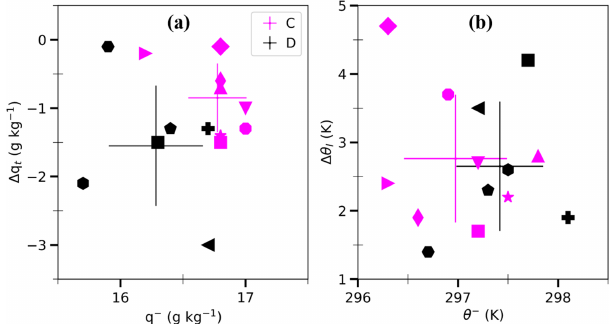
Figure 8. (a) Moisture jump at LLSC top ( (cid:49)q t ) against specific hu- midity at the LLSC base ( q − ) and (b) temperature jump at LLSC top (cid:49)θ l (possible underestimation of around 1.2K) against poten- tial temperature at the LLSC base ( θ − ) derived from 14 05:00UTC standard morning soundings for which the probe flew within the LLSC layer (Table A1). In each panel, the error bars correspond to the standard deviation and crosses at the mean over all C (magenta) and D (black) cases. Each symbol represents a single case. Table 1. Medians and standard deviations of some parameters in the RAD, ENT and SUBS formulations estimated from the 14 05:00UTC radiosoundings presented in Fig. 8. The standard de- viation (in brackets) of the cases is not indicated when negligible. Our results are compared with the values used in van der Dussen et al.